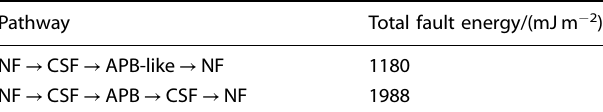
Table 1. Total energies of faults created for the distinctive pathways of the γ "